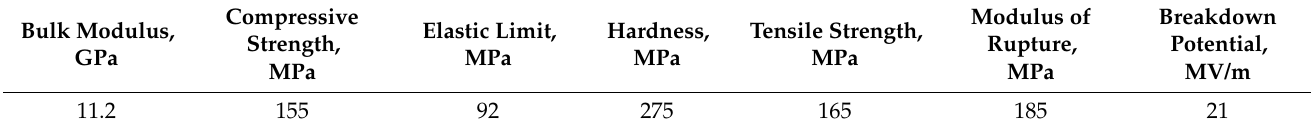
Table 1. Properties of the PBT-GF30.